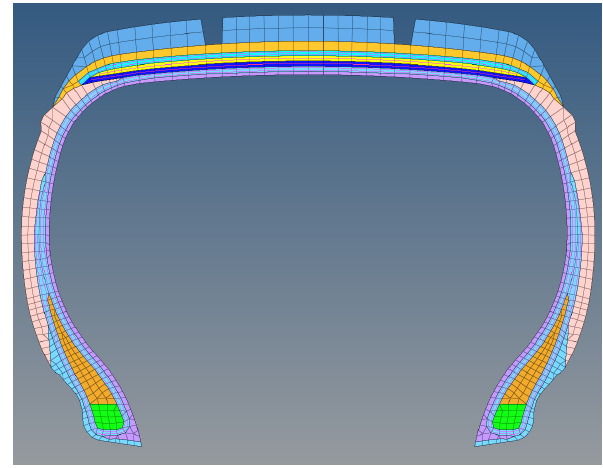
Figure 10. 2-dimensional finite element model.